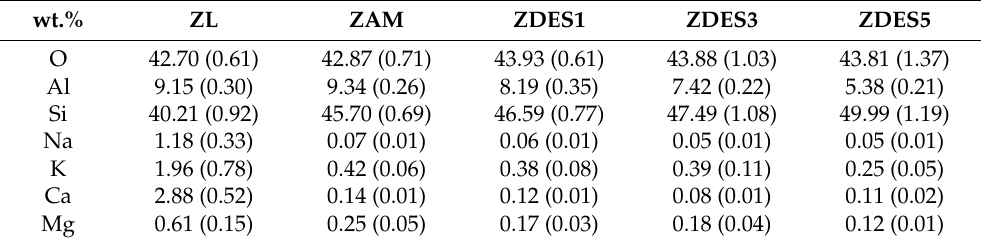
Table 2. Elemental chemical analysis of: raw material (ZL), ammonia-exchanged form (ZAM), and dealuminated samples (ZDES1, ZDES3, and ZDES5). The values in parenthesis are the standard deviation error of each element.